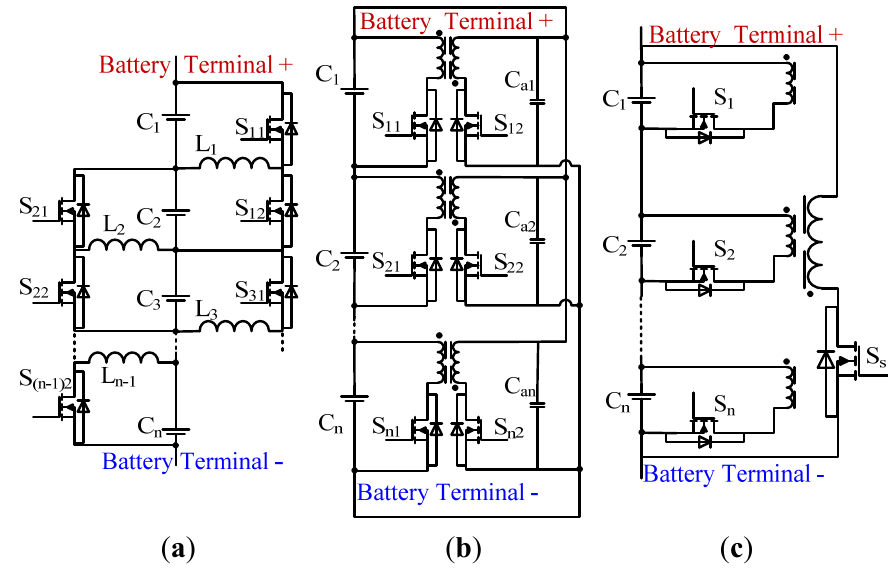
Figure 1. Several existing active balancing topologies: ( a ) Bidirectional buck-boost convertor balancing topology; ( b ) Traditional bidirectional flyback converter balancing topology; ( c ) Shared transformer flyback converter balancing